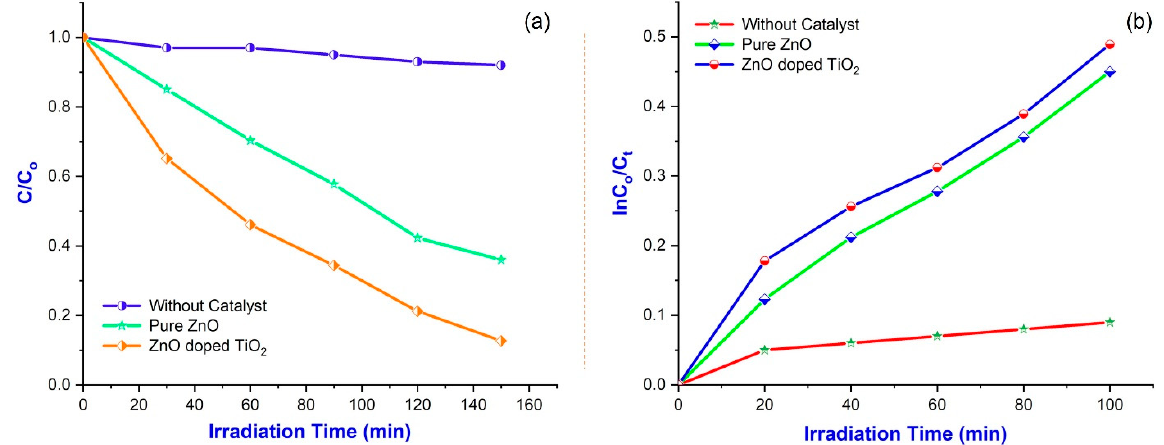
Figure 9. ( a , b ) Infrared irradiation time-dependence of (C/C o ) and light-exposure time-dependence of (C/C t ) for ZnO-doped TiO 2 nanocomposites.